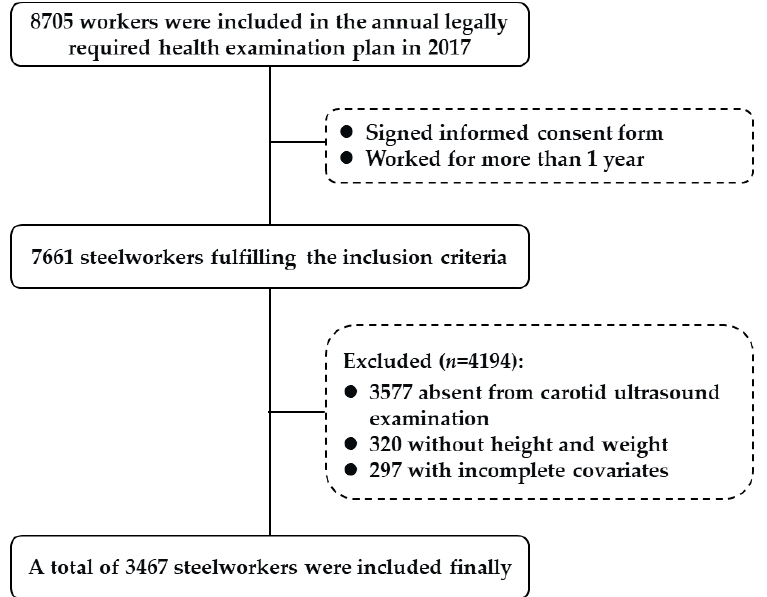
Figure 1. Flowchart of the participant selection.